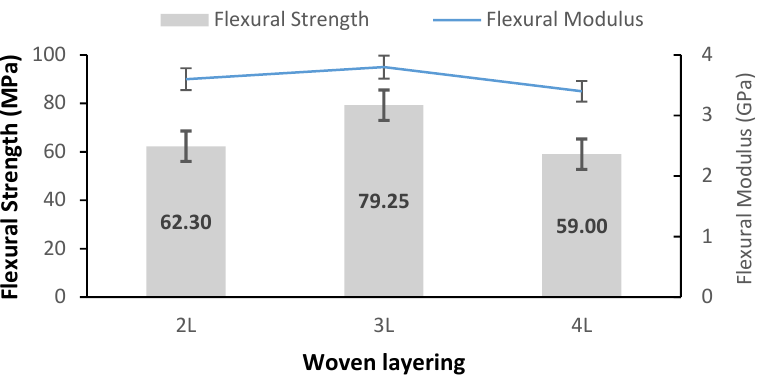
Figure 4. Flexural properties of woven PALF-reinforced epoxy composite at different layering num- bers.